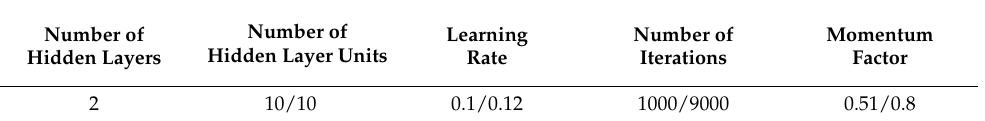
Table 3. DBN network parameters.